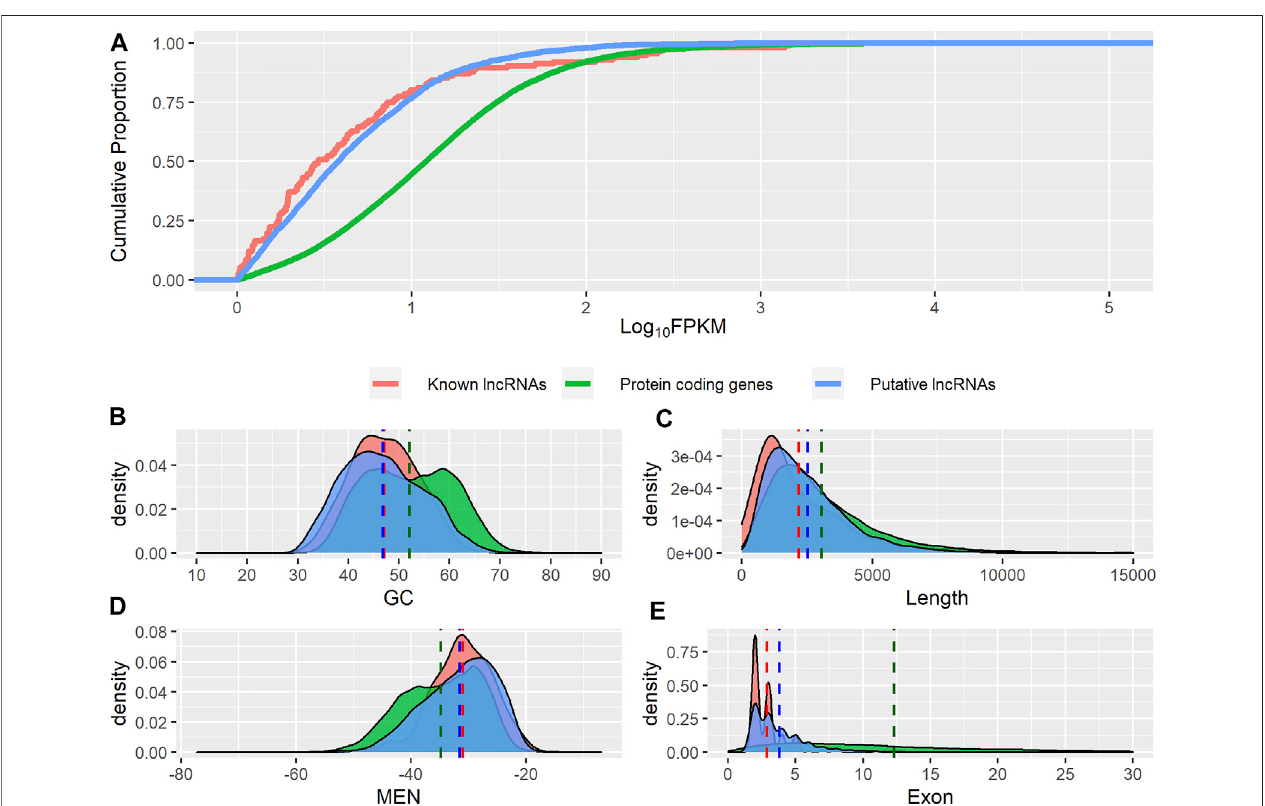
FIGURE 3 | Genomic features of putative lncRNAs, known lncRNAs, and protein-coding genes. (A) Comparison of expression level. (B) Distribution of guanine- cytosine content (GC). (C) Distribution of transcripts length. (D) Distribution of normalized minimum free energy (MEN). (E) Distribution of number of exons.